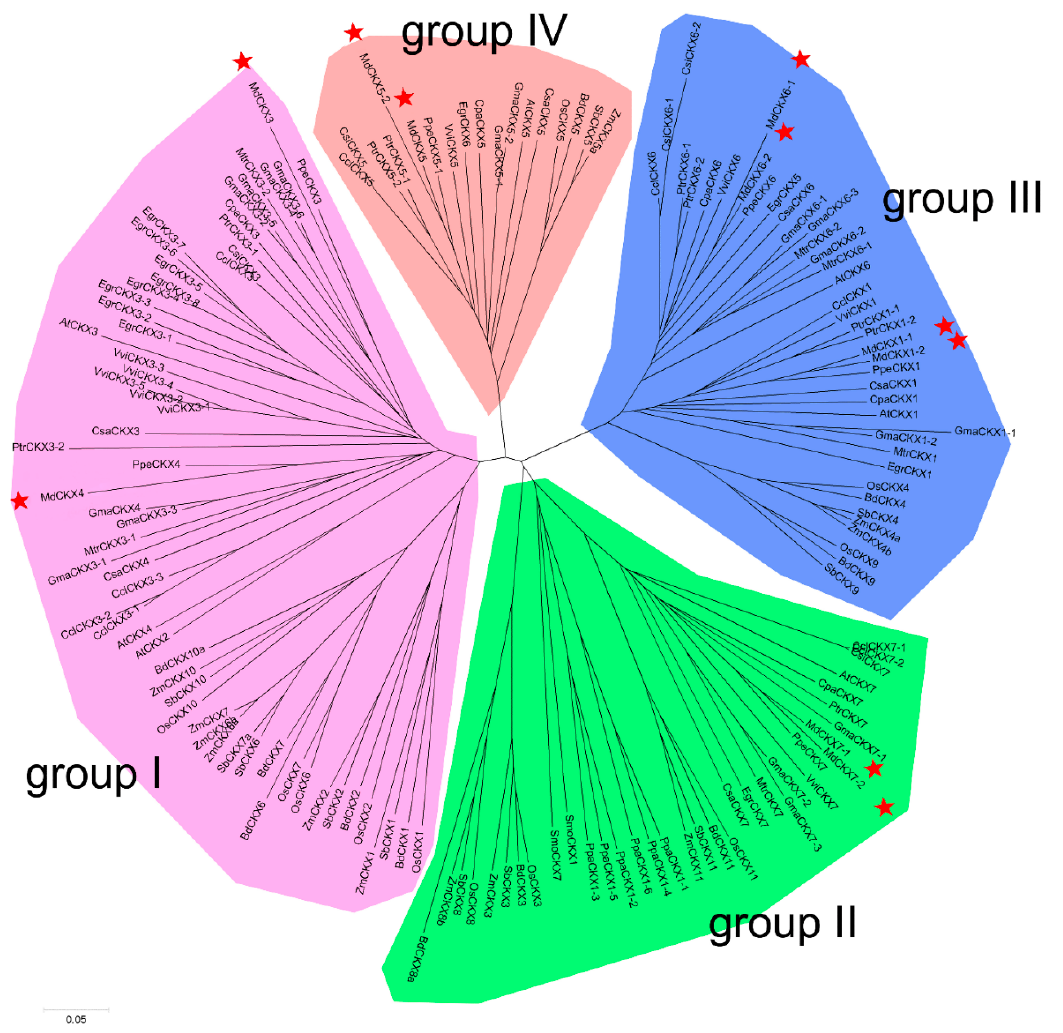
Figure 1. Phylogenetic analysis of the MdCKX proteins. Different colors represent different branches of group. Red stars indicate apple CKX proteins.